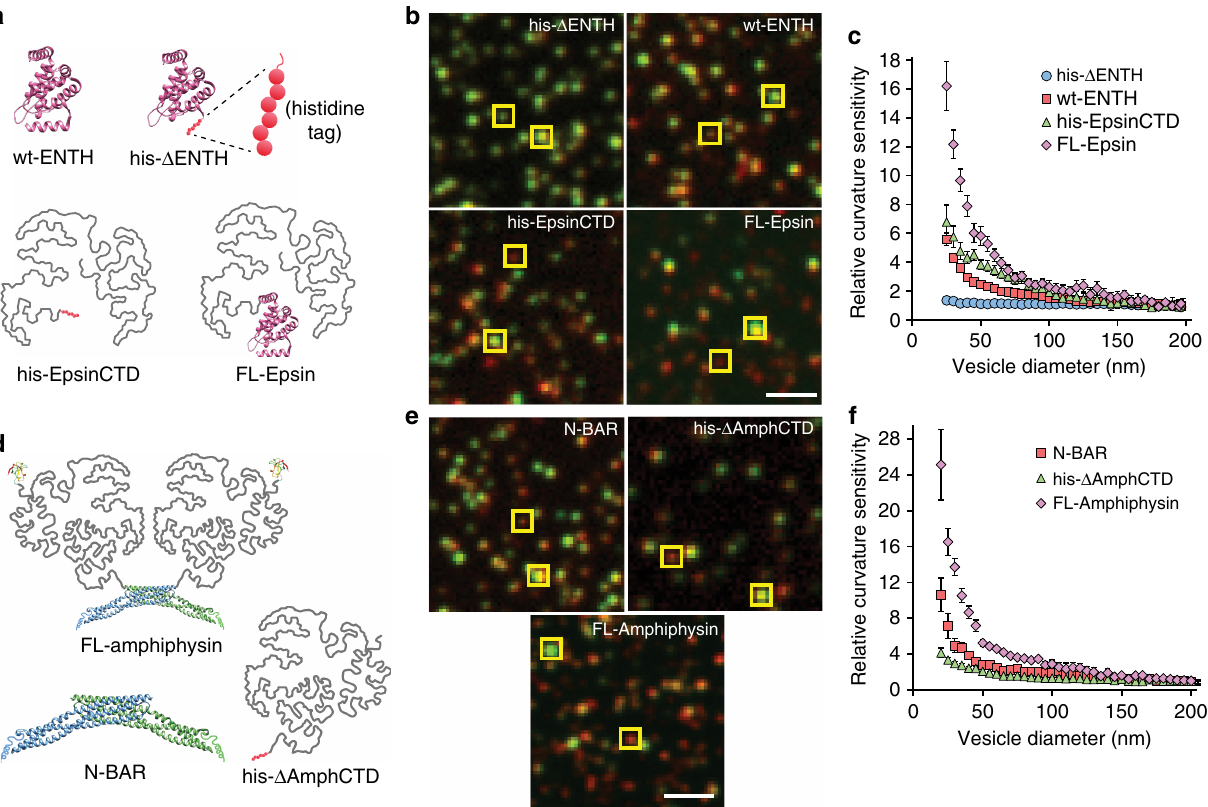
Fig. 5 Disordered domains enhance curvature sensitivity of structured domains. a Schematic of Epsin1 domains and full-length protein. b Lipid, protein, and merged confocal fl uorescent images of SUVs (30 nm extruded) and bound proteins. Yellow boxes highlight SUVs of varying brightness, corresponding to varying diameter. Protein (red) to lipid (green) fl uorescence ratio appears higher for smaller (less bright in lipid channel) SUVs. SUVs used for his- Δ ENTH and his-EpsinCTD binding contained 80% DOPC, 16% DGS-NTA, 2% DP-EG10-biotin, and 2% Oregon Green-DHPE. SUVs used for wt-ENTH and